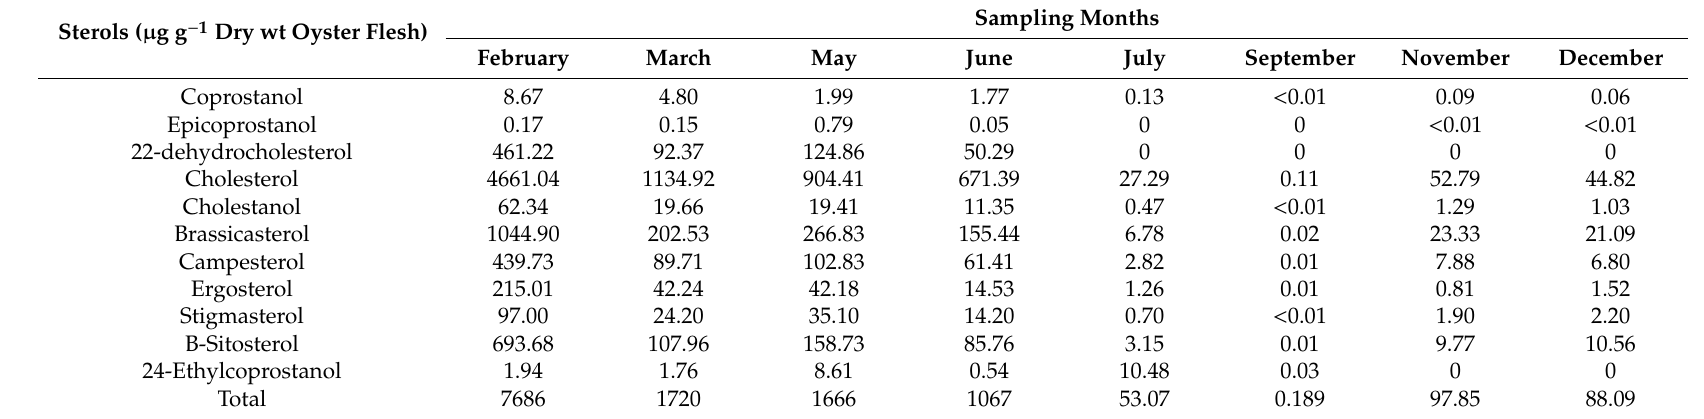
Table 3. Concentrations of 11 major sterols and total sterols ( µ g g − 1 dry wt oyster flesh) in oysters collected from Salcott Creek over 12